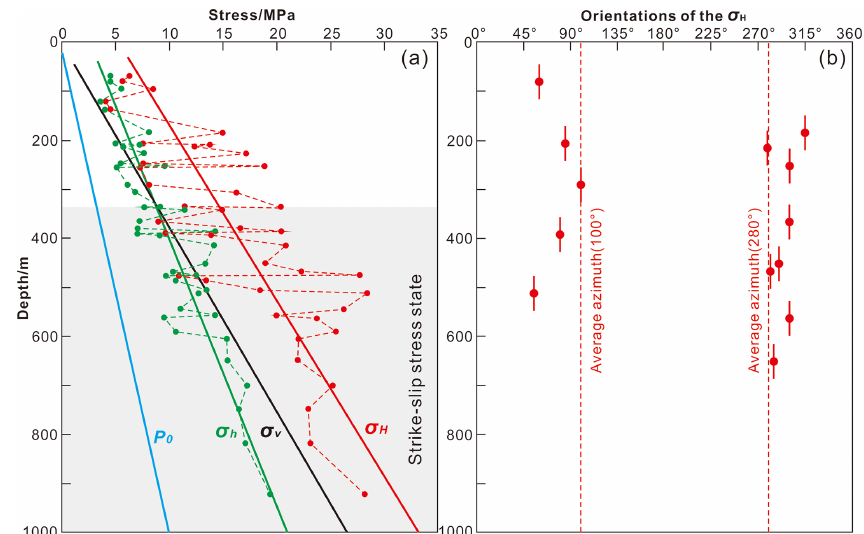
Figure 5. Hydraulic fracturing in situ stress results at shallow depths ( < 1000m) near the MTY EGS field in the Tangshan seismic region. (a) The magnitudes of three principal stresses with depth. (b) The orientations of the maximum horizontal principal stress ( σ H ). Table 3. The tensorial mean of hydraulic fracturing in situ stress results at similar depths in three boreholes near the MTY EGS